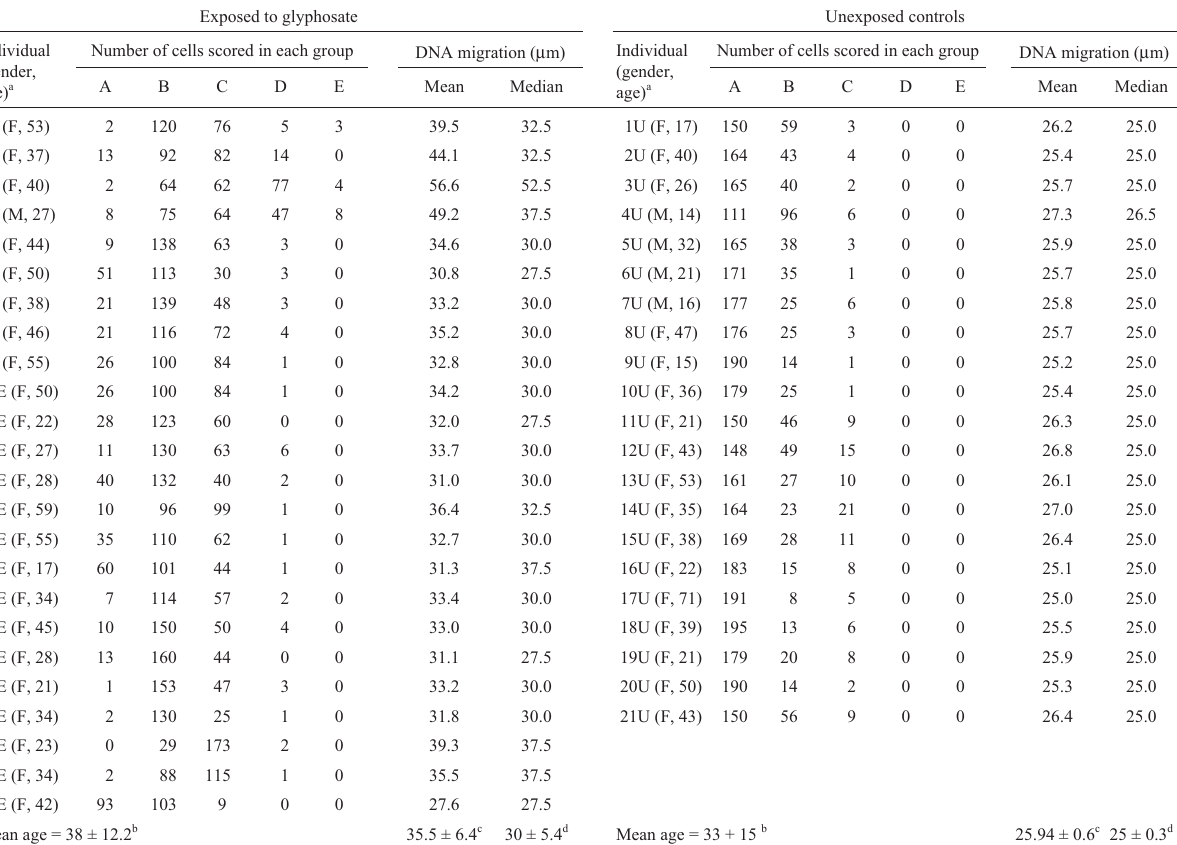
Table 1 - DNA damage assessed by the comet assay in individuals exposed (E) to glyphosate and unexposed (U) control individuals. Note that the same numbers (1, 2, 3 etc.) for the individuals does not indicate that the exposed and control individuals were matched. Exposed to